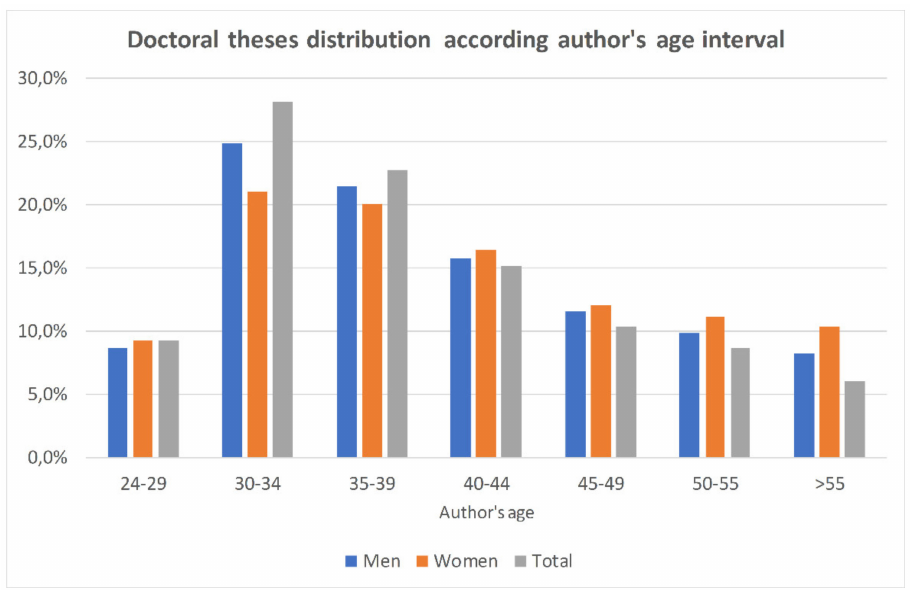
Figure 1. Distribution of women’s and men’s ages in doctoral theses production.